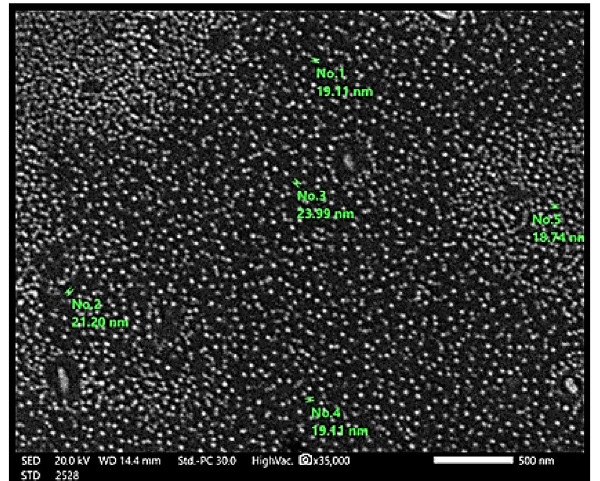
Figure 3. SEM image of Fe 0.75 Cu 0.25 -BDC@Alg-MoO 3